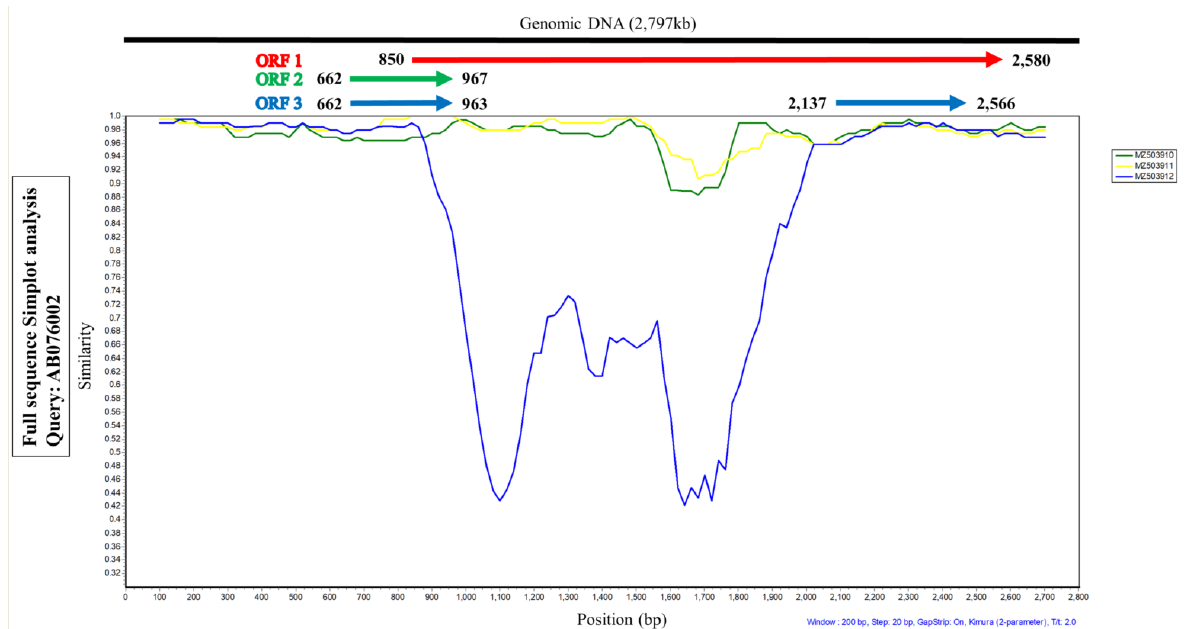
Figure 2. Similarity plot analysis using the three full-length genomes of TTCaV isolated in this study and the Japanese prototype Cf-TTV10 (query). ORF1 region of the MZ503912 strain showed lower similarities than the other two TTCaV strains.